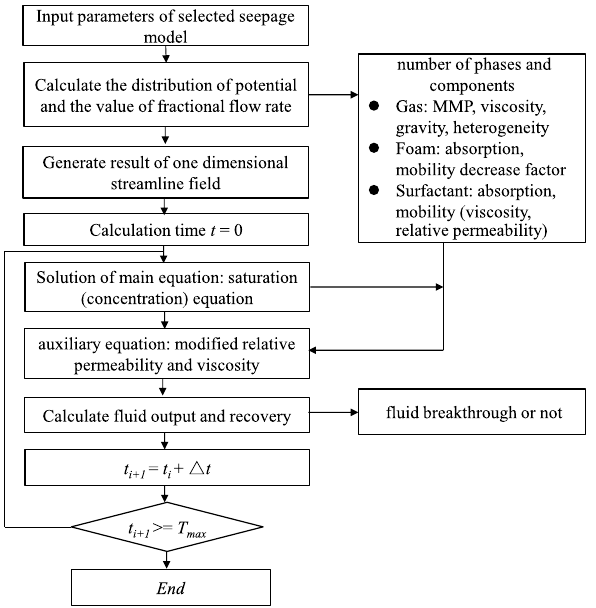
Fig. 3 The numerical calculation procedure